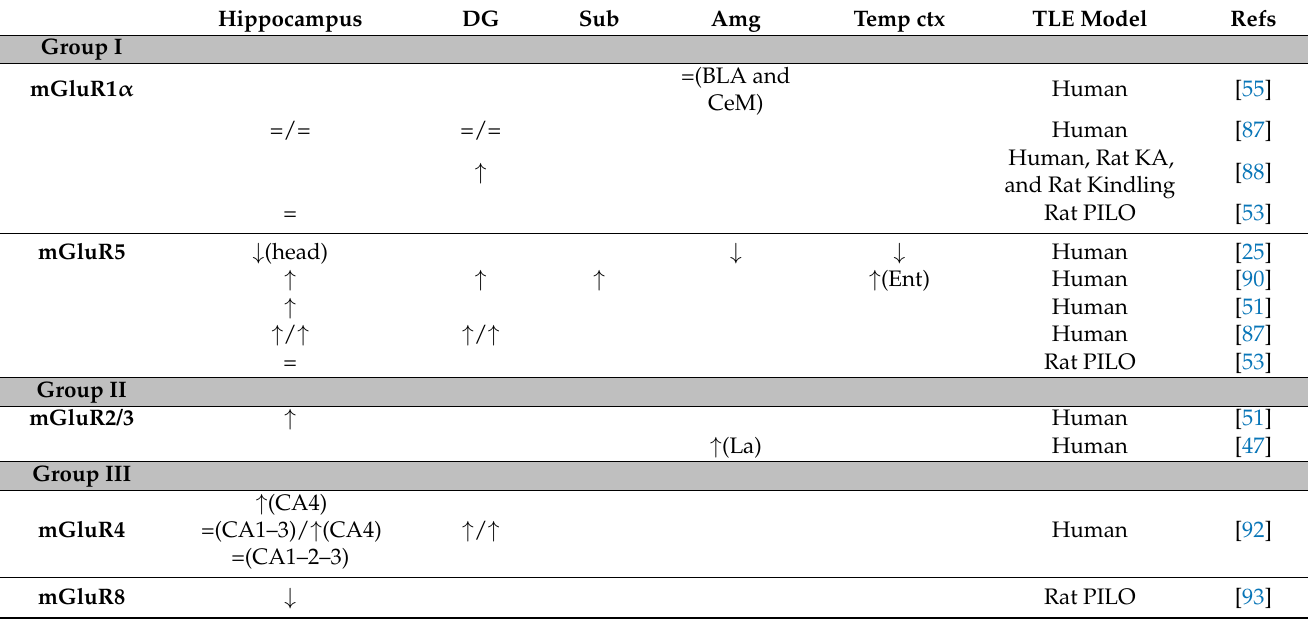
Table 2. Alterations of neuronal glutamatergic metabotropic